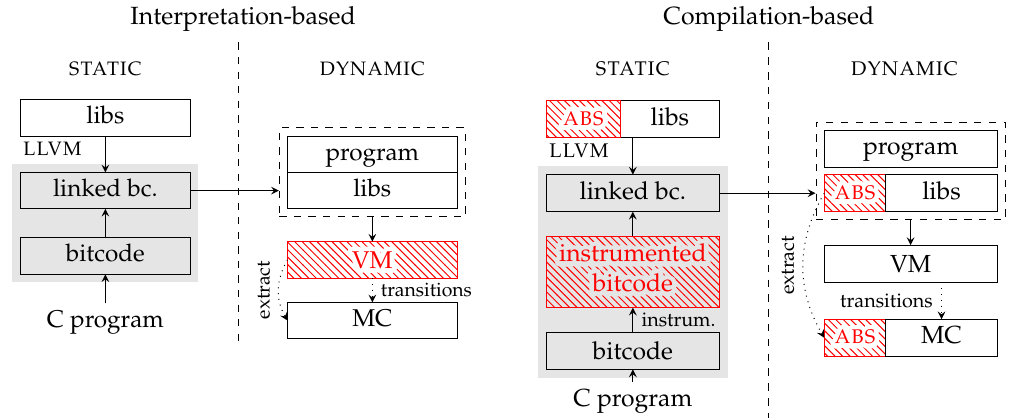
Figure 1. In the figure, we compare an abstract interpretation with a compilation-based